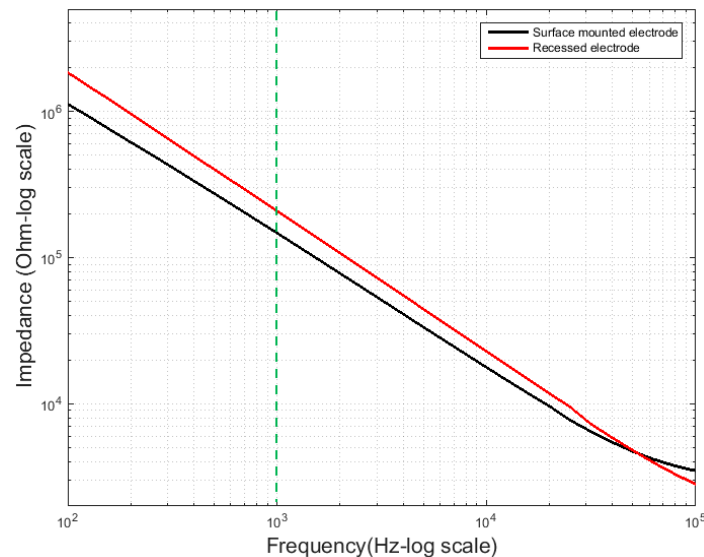
Figure 8. Electrode impedance measurement. Five measurements of electrode impedance on the eight individual electrodes of 10 MEAs are considered. The average electrode impedance curves rely on the electrode area and